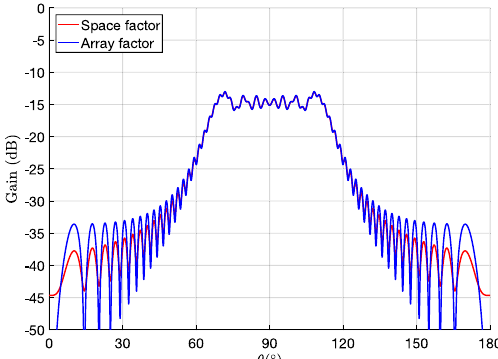
32 (cid:31) ) and array factor ( M